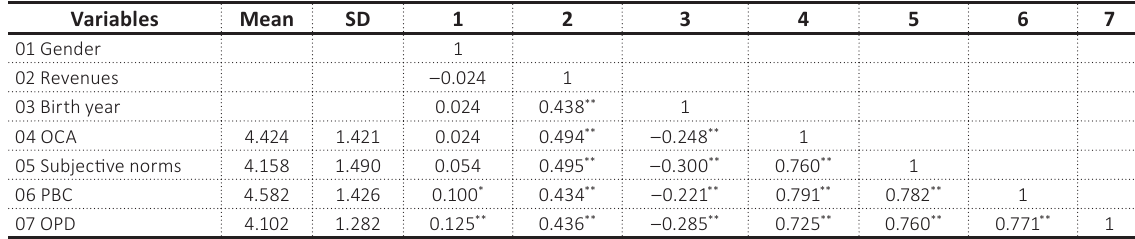
Table 1. Descriptive statistics and correlations